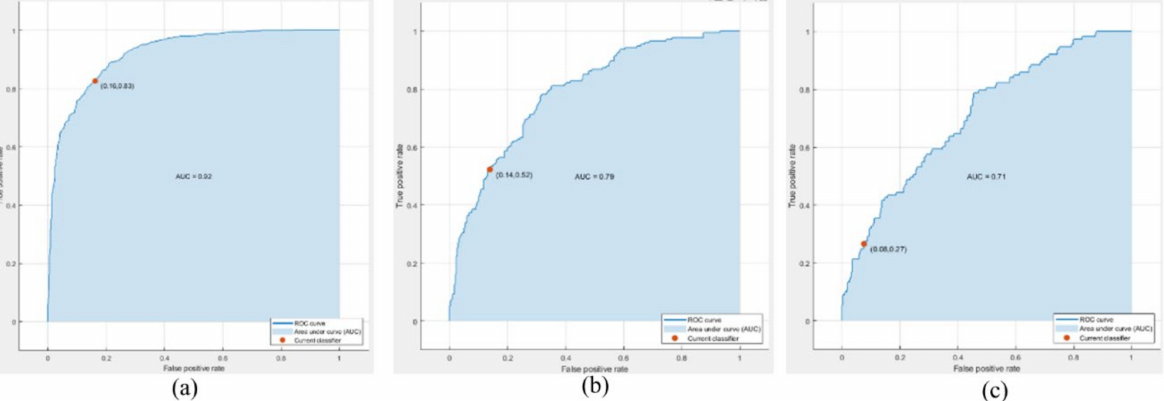
Figure 9. ROC curves and AUC values showing best outcomes of ( a ) mixed views with CSVM, ( b ) back views with QSVM, and ( c ) front views with QSVM of MIT dataset utilizing 1000-feature